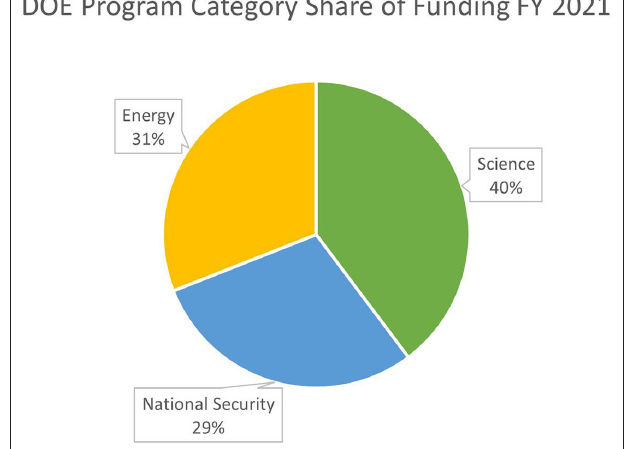
FIGURE 1 | The share of funding for U.S. Department of Energy (DOE)’s spending for fiscal year (FY) 2021 between the three main categories of programs in science, energy and national security. Percentages generated from data retrieved from Congressional Research Service’s Federal Research and Development Funding: FY2022 report, R46869 (Sargent,